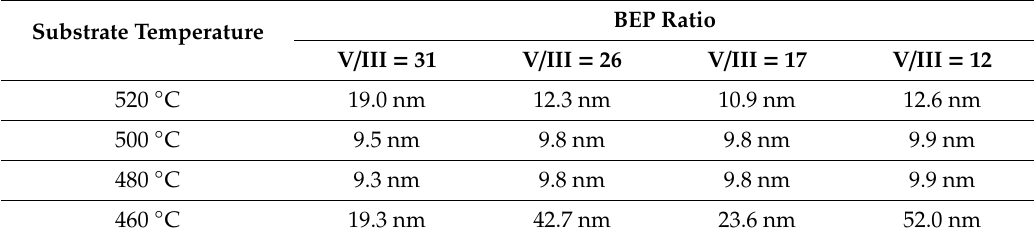
Table 3. The FWHM of the near band edge PL signal for 2.5- µ m In 0.52 Al 0.48 As layer for all investigated substrate temperatures and V/III ratios.